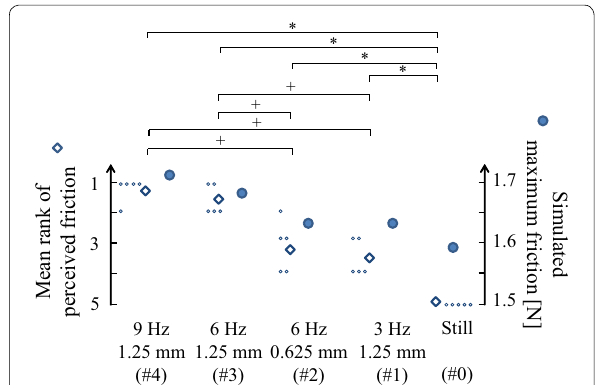
Fig. 8 Order of perceived friction and value of maximum simu- lated friction when ˙ x f = 0.1 m/s and ˙ x r ( t ) > 0 . *p < 0.05, + p < 0.10 (Steel-Dwass test). The smaller dots signify the ranks reported by the individuals, while the larger diamonds signify the mean ranks for all the participants